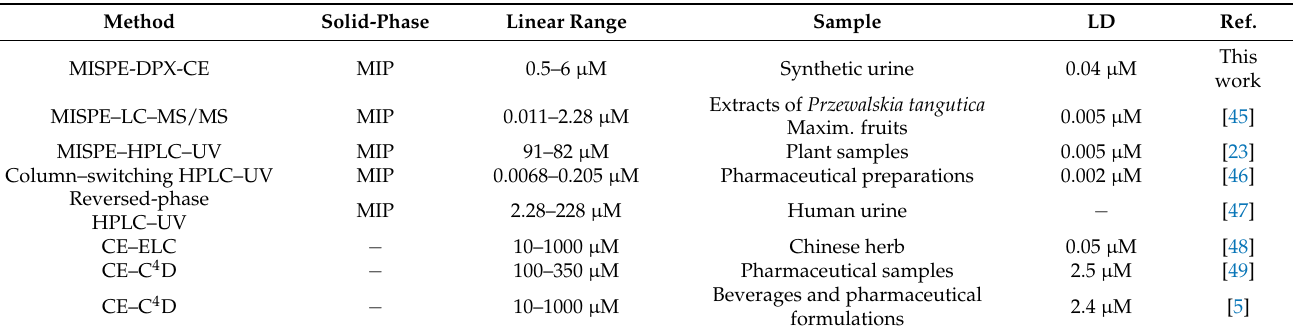
Table 5. Comparison of the analytical performance of the MISPE-DPX-CE method with previously published studies for the preconcentration of